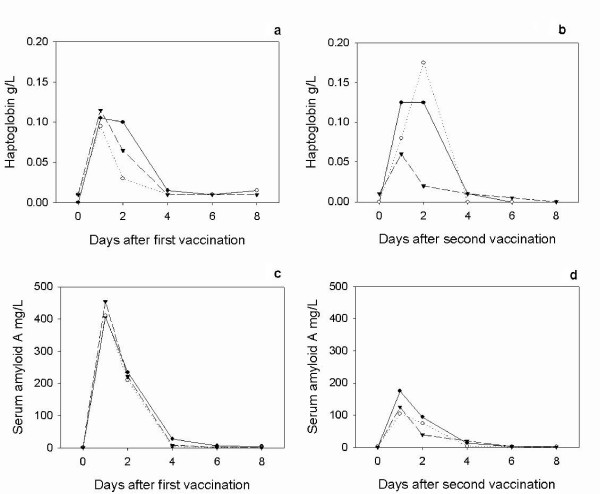
The median concentrations of Hp and SAA in response to the first and second vaccinations with Heptavac. The median concentrations of haptoglobin (a and b) and serum amyloid A (c and d) in lambs (n = 10) following the first (a and c) and second (b and d) vaccinations with Heptavac. The maternal diets of the lambs were High/High (closed circle), High/Low (open circle) and Low/High (triangle).